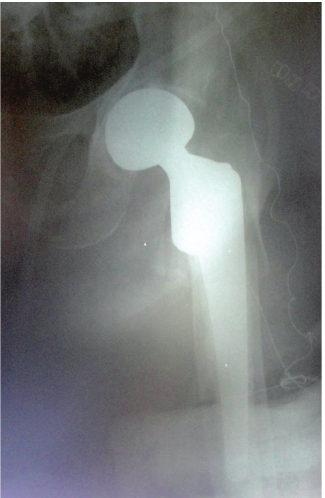
Figure 2: Partial cemented hip arthroplasty was applied with a calcar replacing femoral stem. The femoral stem position was satis- factory in relation to the hip center.